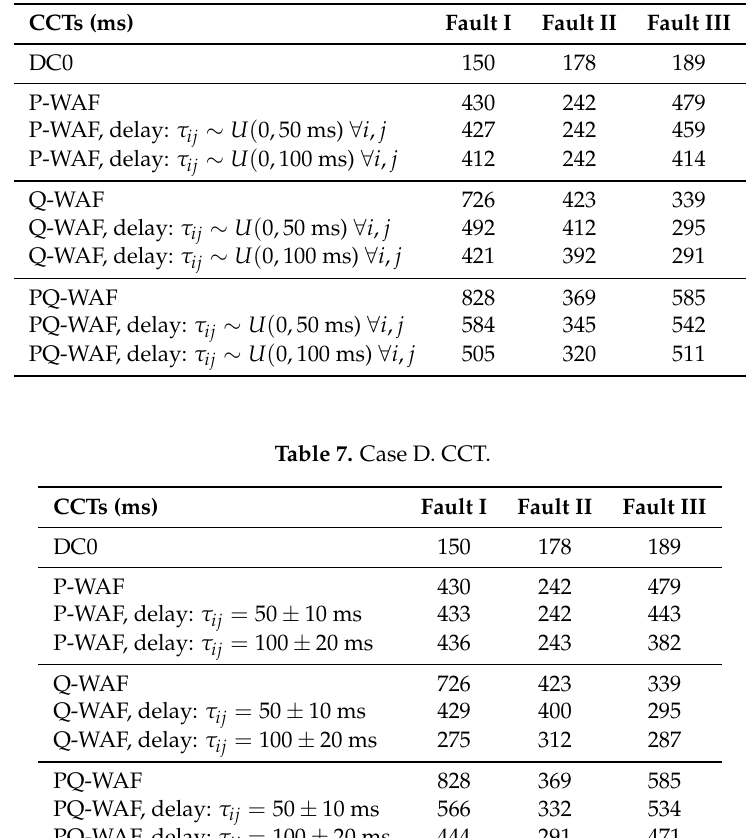
Table 6. Case C. CCT.